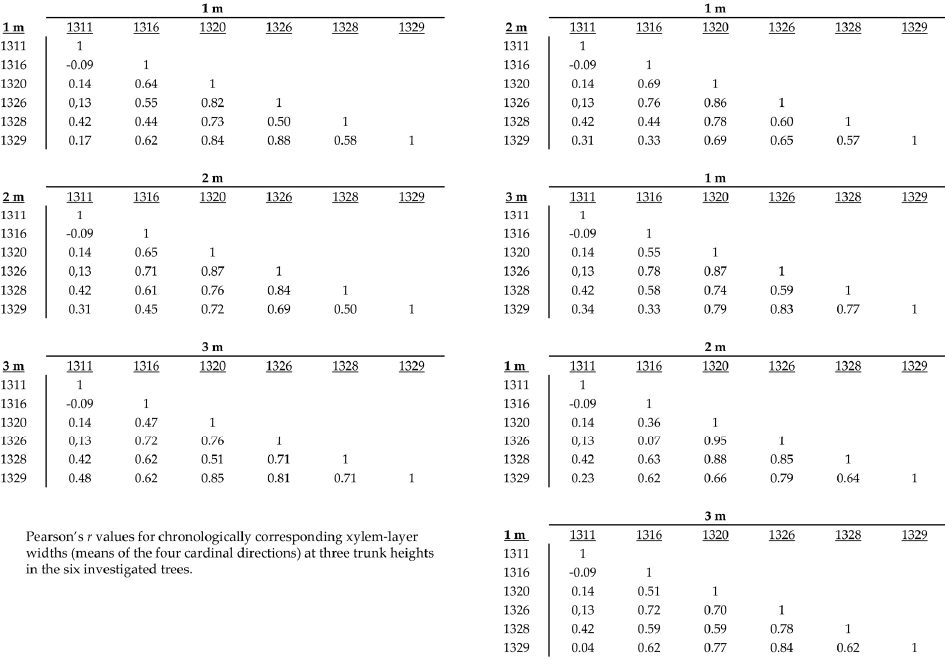
Figure 23. Summary of between tree gišogenesis (ring-width) correlations for all 6 trees, showing only trunk heights 1, 2 and 3 m.